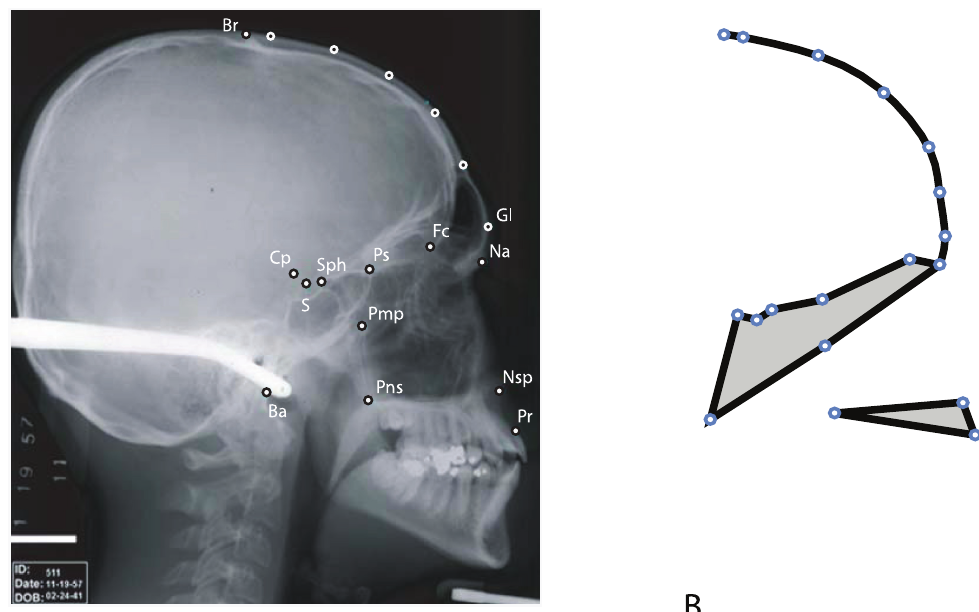
Fig 2. Landmark scheme. (A) A lateral cranial radiograph of an adult human man with 13 anatomical landmarks: basion (Ba), bregma (Br), clival point (CP), foramen ceacum (FC), nasion (Na), nasospinale (Nsp), greater wings of the sphenoid (Pmp), prosthion (Pr), posterior nasal spine (Pns), planum sphenoideum (PS), sella (S), sphenoidale (Sph), and glabella (Gl). Glabella as well as five points along the frontal bone were treated as semilandmarks; their exact locations were estimated by the sliding landmark algorithm. (B) Mean shape configuration of these 18 landmarks in the sample of 26 individuals, measured from birth to adulthood. The midsagittal outline of the frontal bone is represented by the black curve, and the shape of the cranial base and the maxilla by the two